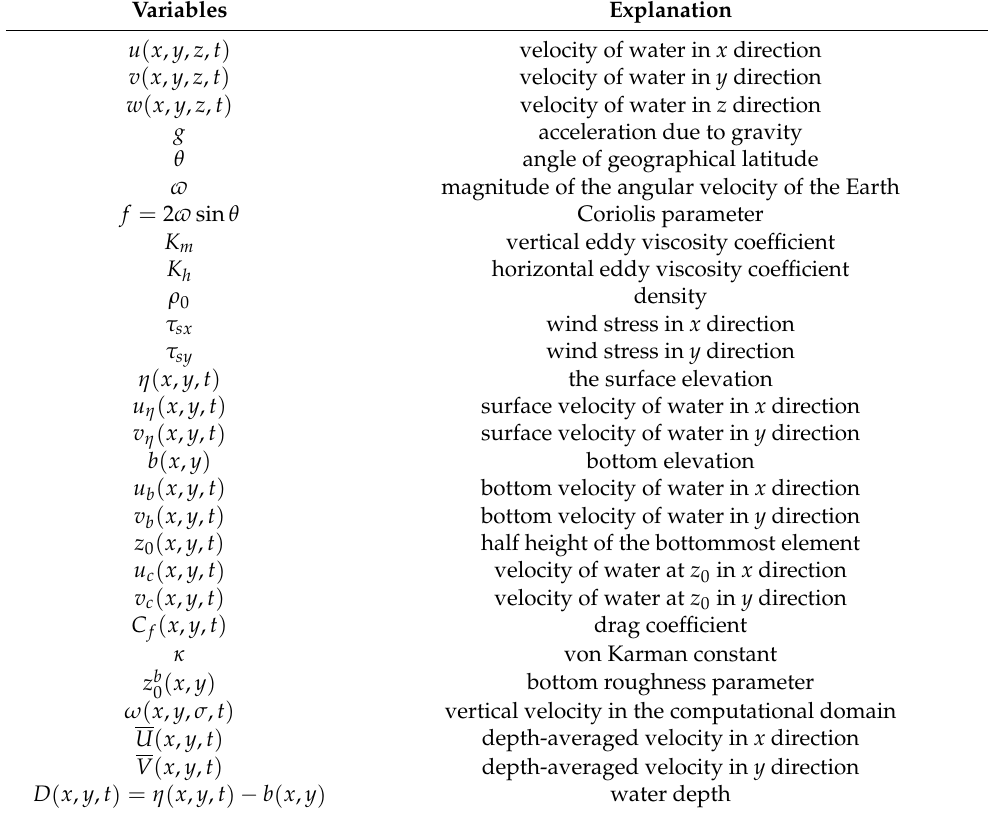
surface velocity of water in x